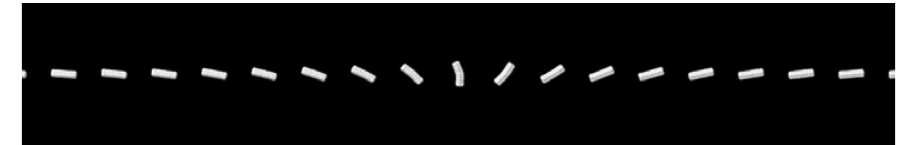
Figure 11. Microrods of 400 µ m length rotating along the needle (needle size 0.8 mm, flow rate: 100 µL/min).